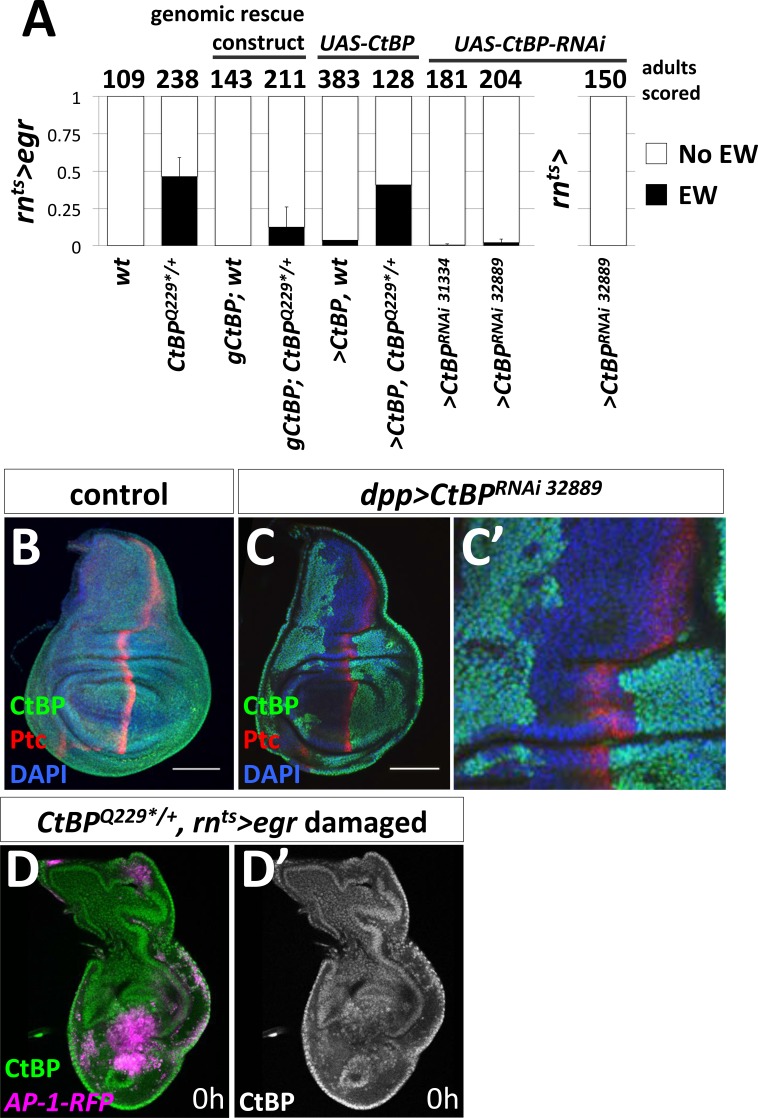
CtBP acts outside of the rn-GAL4 domain to prevent damage-induced ectopic wings.(A) Frequency of ectopic wings (EW) following rnts>egr damage as calculated by the fraction of adults without (no EW) and those with one or two ectopic wings (EW) from multiple biological replicates in listed genetic backgrounds. gCtBP is a genomic rescue construct that is located at attp40 (Zhang and Arnosti, 2011). Last column is rnts> control for >CtBPRNAi. Error bars show standard deviations. Numbers above bars represent the total number of adults scored for each genotype. (B–C) Wing imaginal discs stained with antibodies against CtBP and Patched (Ptc) in control (B) and with dpp-GAL4 driving the expression of UAS-CtBPRNAi (BL:32889) (C). CtBP immunoreactivity is lost in cells that currently express dpp-GAL4, which significantly overlaps with Ptc expression domain, as well as more anterior cells that expressed it earlier in development (likely due to RNAi persistence [Bosch et al., 2016]). (D) Wing disc following rnts>egr damage in CtBPQ229*/+ genetic background with AP-1-RFP reporter showing activation in the notum, stained with anti-CtBP. Note relatively uniform expression of CtBP (D’).